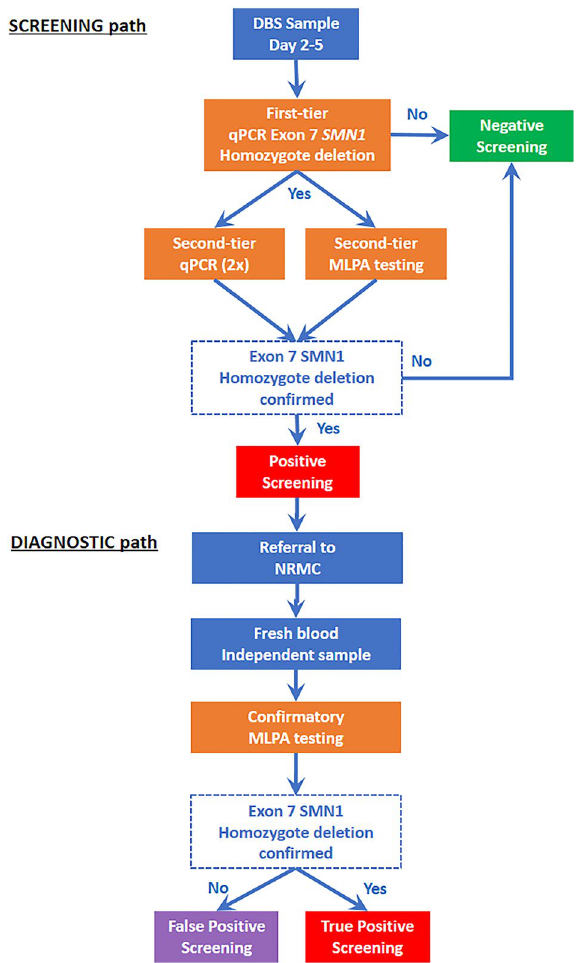
Figure 3. Screening and diagnostic